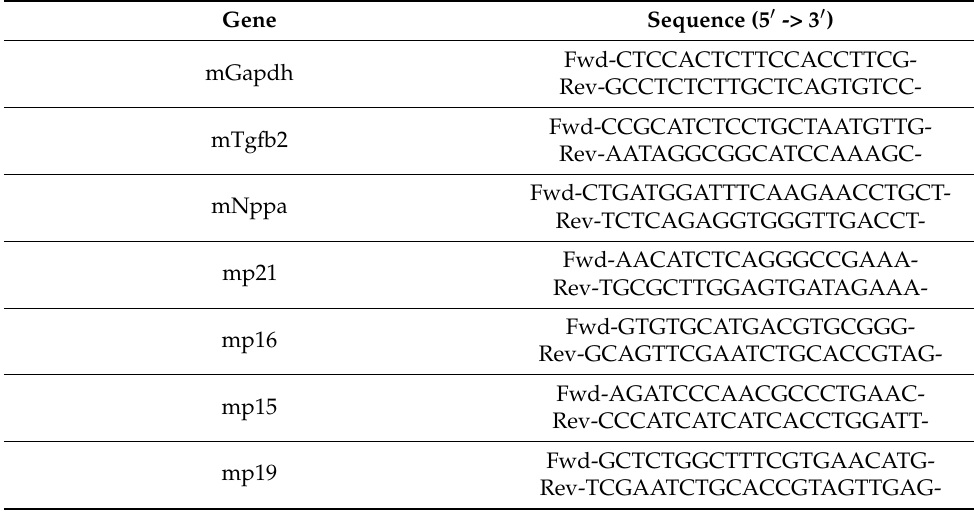
Table 2. List of